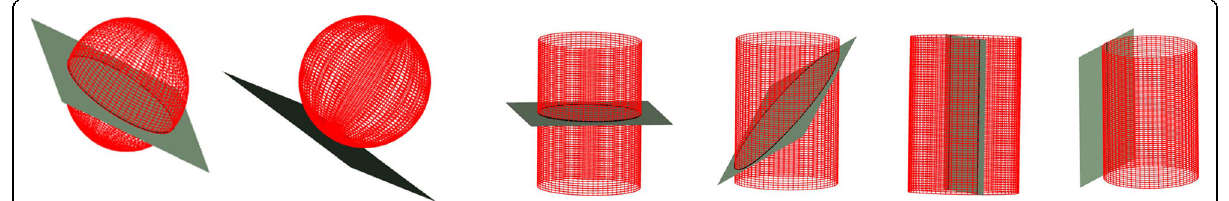
Fig. 2 Intersection results depend on directions of surfaces and slicing planes